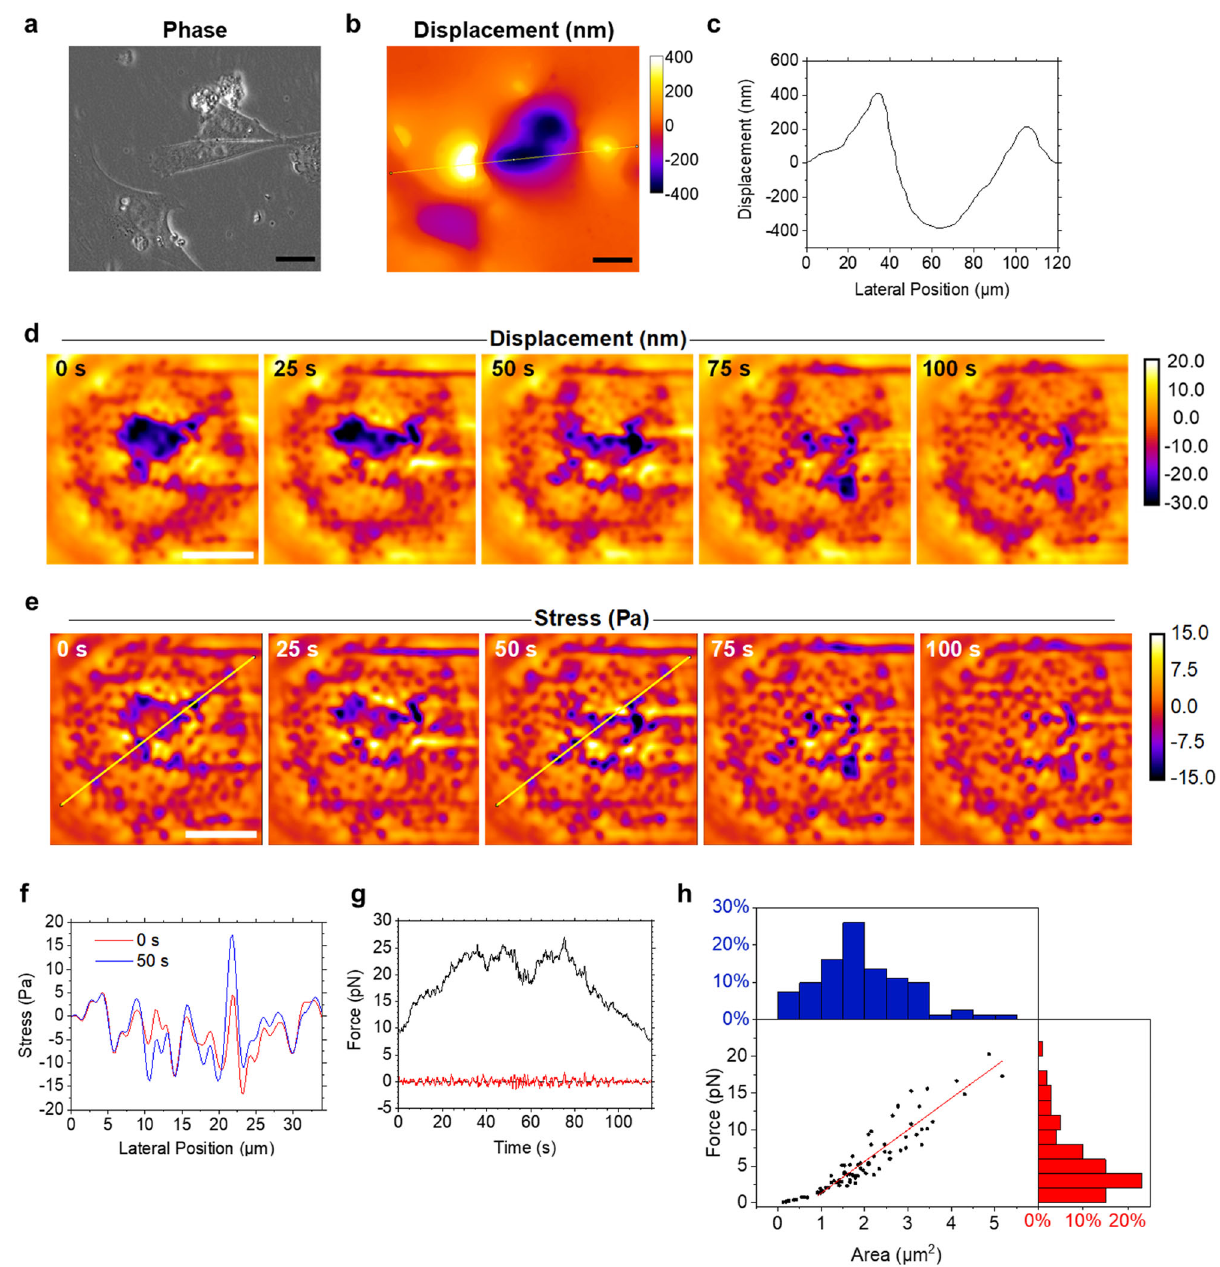
Fig. 3 Real-time imaging of cellular forces. a Phase-contrast microscopy image of NIH-3T3 cells on the surface of a microcavity chip. b Displacement map for the same fi eld of view as in a , generated in real-time while scanning across the surface of the chip by moving the microscope stage. c Pro fi le along the yellow line in b . d Selected frames from live force imaging of a macrophage at 17 fps, showing the microcavity displacement caused by podosome protrusions. Spatial Fourier- fi ltering was applied to emphasise podosome protrusions against the background of broad indentation generated by the cell. e Maps of the stress exerted by the podosome protrusions as obtained from the displacement time-lapse in d using FEM model analysis. f Plot along the line in e at two different time points, showing the fl uctuations of podosome stress. g Force exerted by a typical podosome over time (black, fi ltered with 0.5 s moving average). Applying an additional high pass temporal Fourier fi lter (cutoff frequency, 0.2 Hz) removes the slowly varying features and resolves the fast pN fl uctuations in force more clearly (red). h Analysis of correlation between podosomal force and area of indentation for n = 81 podosomes (black symbols). Red line indicates linear fi t to the data ( R 2 = 0.85) for podosome areas >0.7 µ m 2 . Histograms of podosomal forces (red) and area of indentation (blue) for all podosomes analysed in the main plot. Scale bars, 20 µ m a , b ; 10 µ m d , e . Images in a and b are representative of 20 independent observations from one experiment. Images in d and e are representative of three independent observations from one